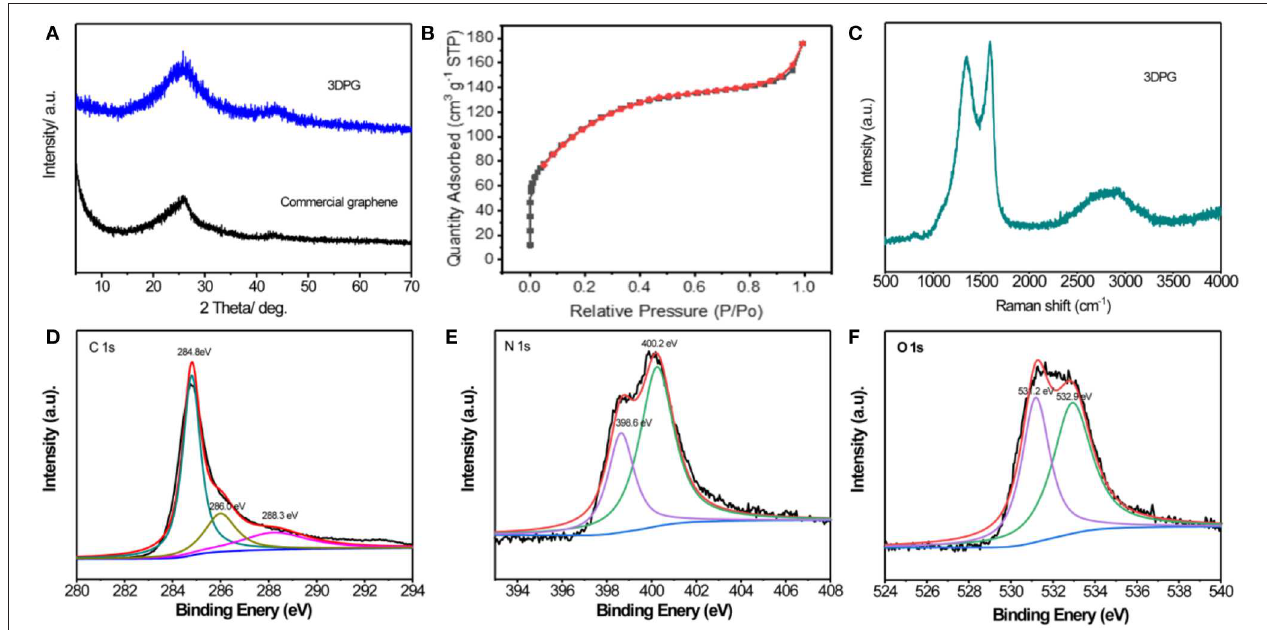
FIGURE 2 | (A) XRD patterns of 3DPG and commercial graphene, (B) Nitrogen adsorption isotherm at 77K, (C) Raman spectra and (D) C 1s, (E) N 1s, (F) O 1s XPS spectrums of 3DPG.